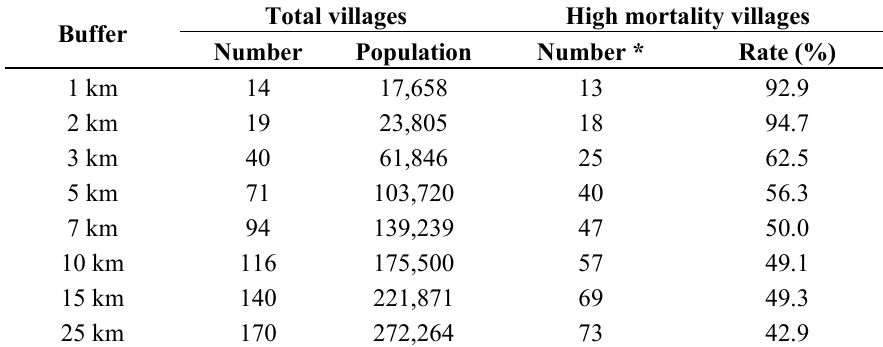
Table 5. Villages and population distribution in different buffers in Suxian District in 2010. Total Buffer